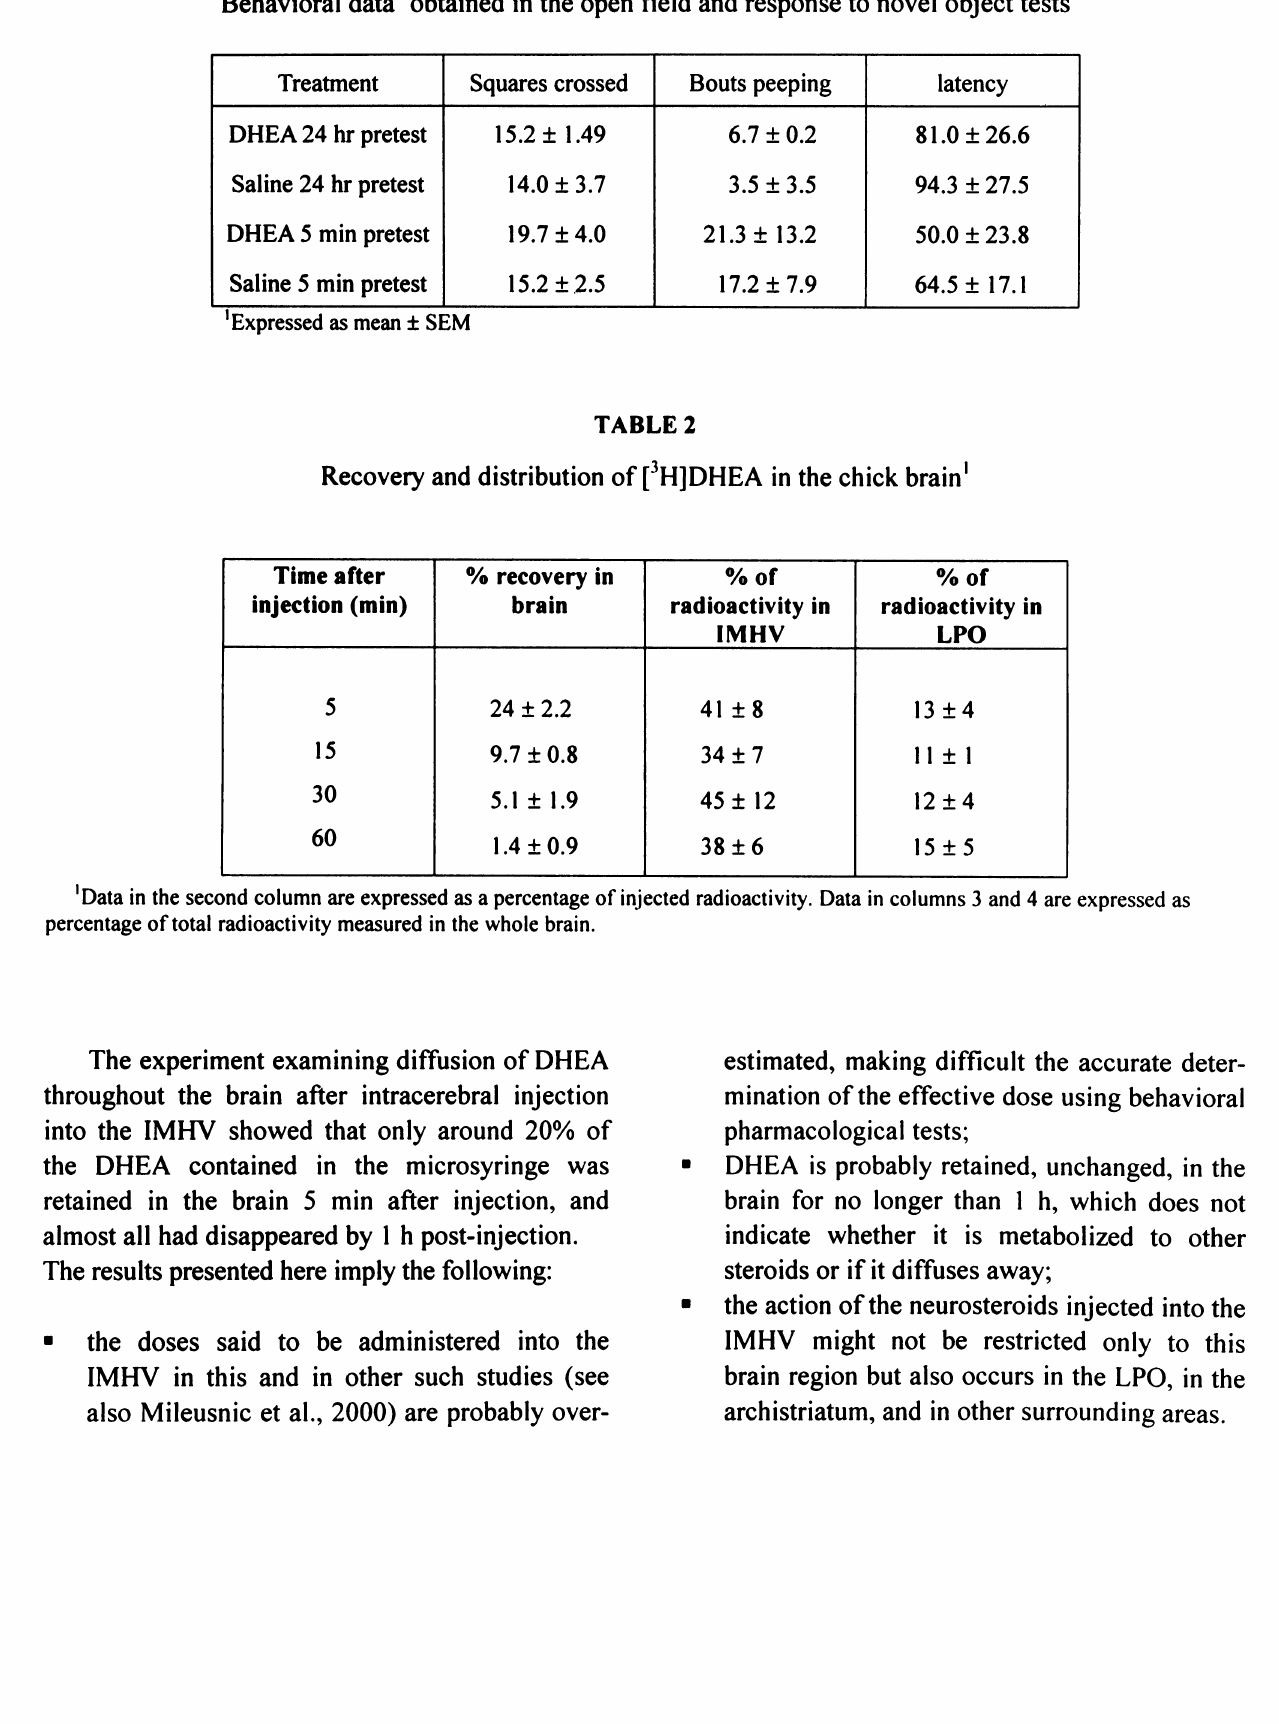
Behavioral data obtained in the open field and response to novel object tests